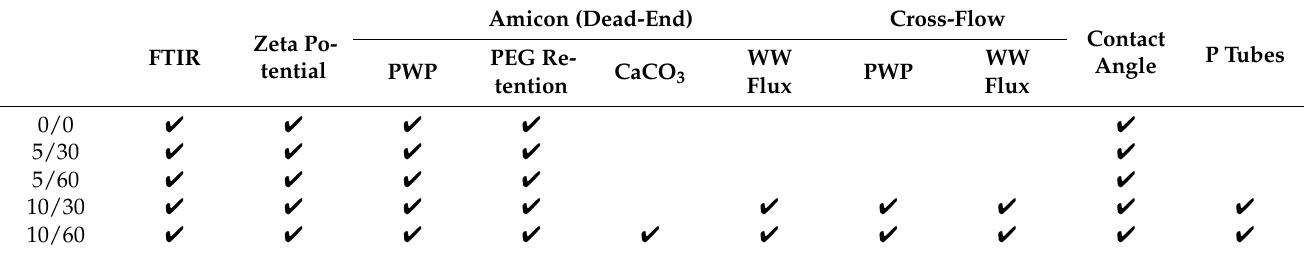
Table 2. An overview of the